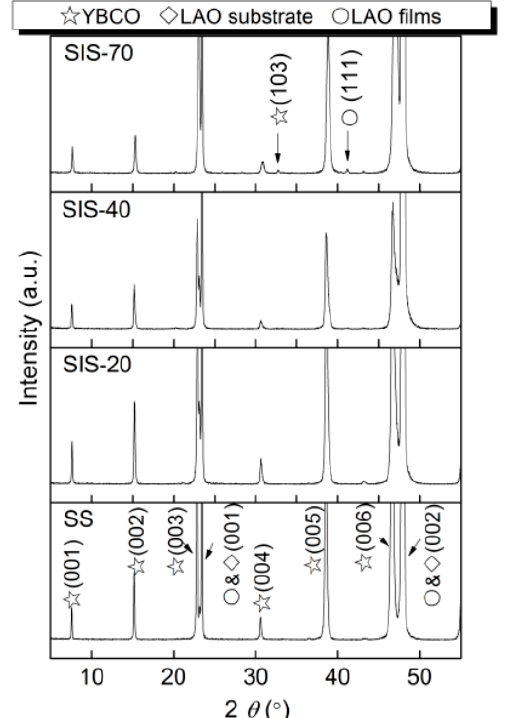
Figure 3. XRD patterns of the YBCO/LAO/YBCO trilayer films.